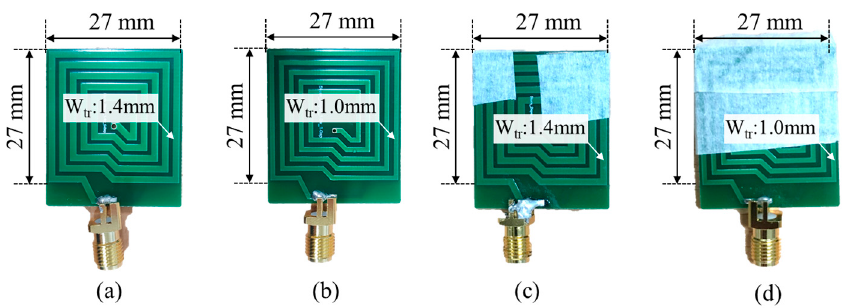
Figure 10. Transmitting coil fabricated to validate the proposed approach. ( a ) Fabricated coil with 1.4 mm trace width and 5 turns, 2 layers, ( b ) fabricated coil with 1.0 mm trace width and 5 turns, 2 layers, ( c ) fabricated coil with 1.4 mm and 5 turns, 4 layers. ( d ) Fabricated coil with 1.0 mm and 5 turns, 4 layers.